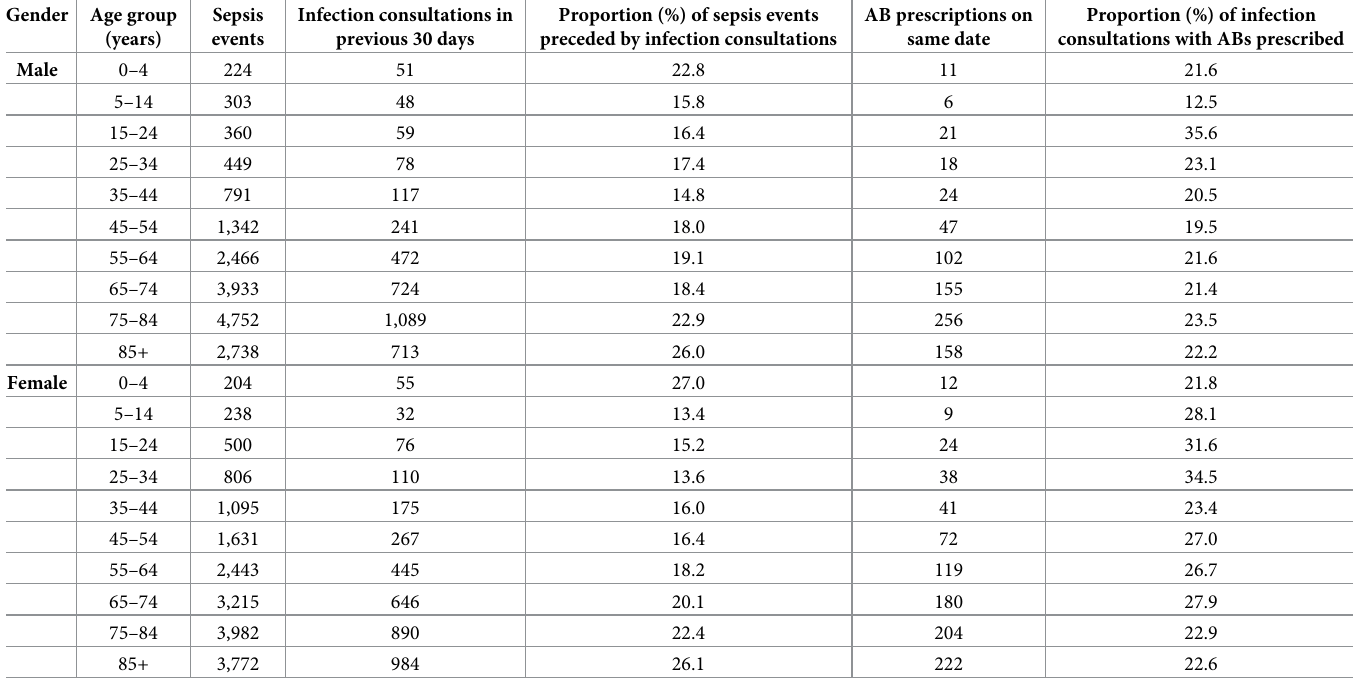
Table 2. First sepsis events recorded in CPRD from 2002 to 2017 and preceding infection consultations and AB prescriptions. Gender Age group Sepsis (years) events